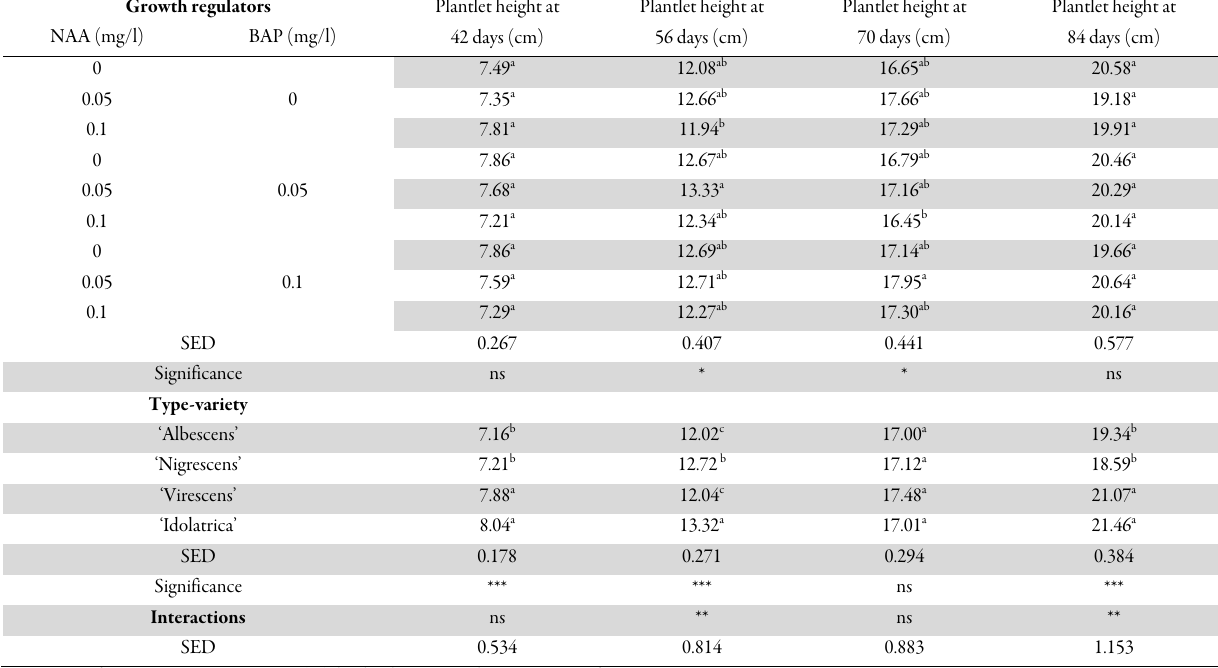
Table 2. Effects of growth regulators and type-variety of oil palm on plantlet heights at 42, 56, 70 and 84 days after culture initiation Growth